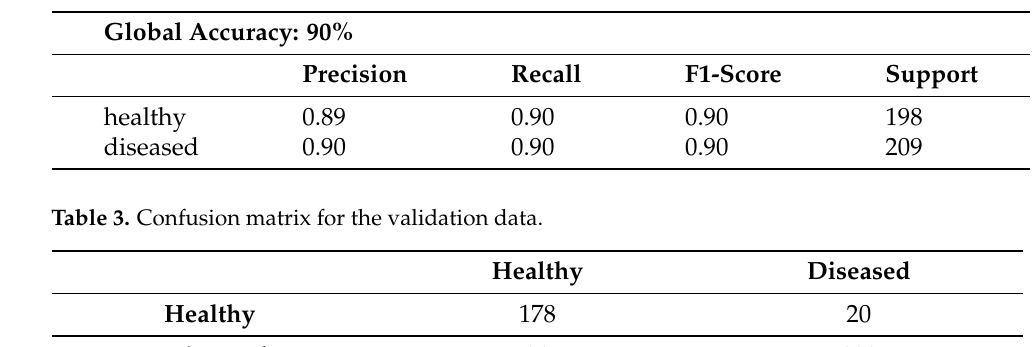
Table 2. Metric results for the validation dataset. This set was obtained separating 10% of the training data for validation.